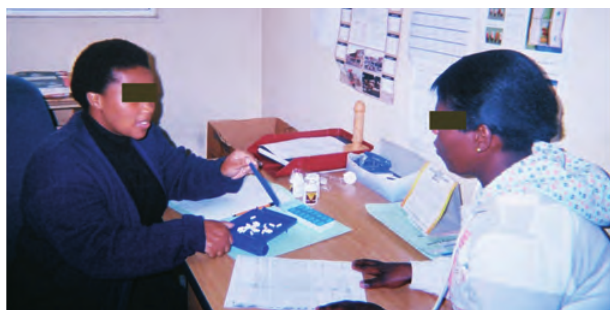
Fig. 2. A counsellor explaining medication parameters to a patient.